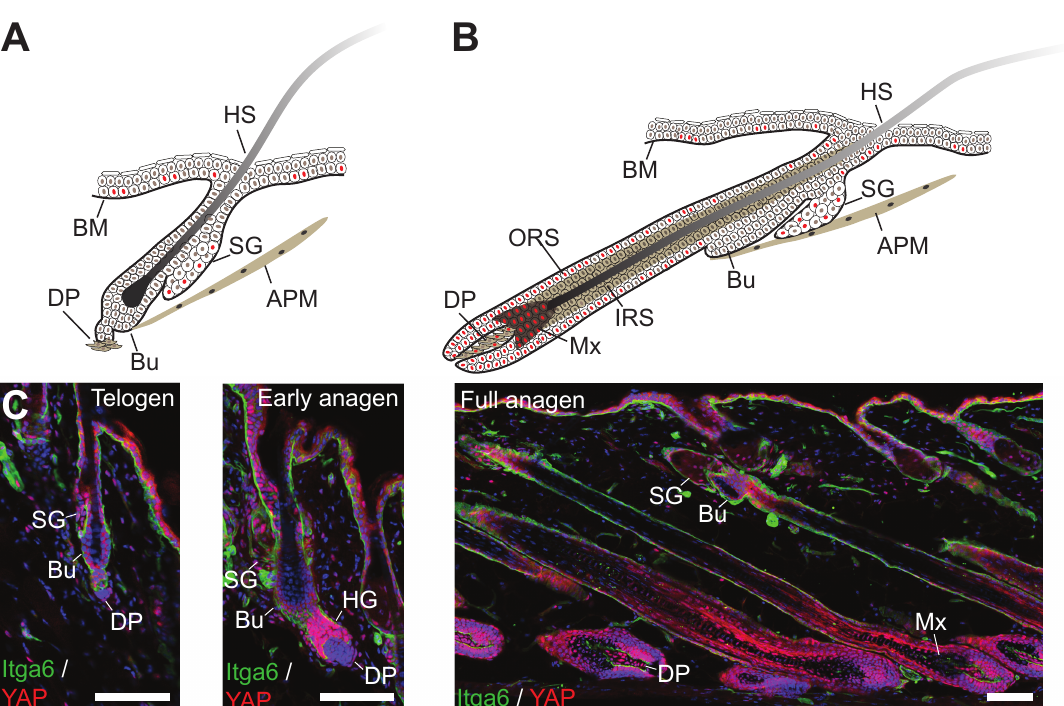
Figure 3. YAP localisation during HF cycling. ( A , B ) Schematic of a HF in the resting phase (telogen) (A) and growth phase (anagen) (B). In telogen phase, YAP is mainly localised to the cytoplasm in bulge and DP cells and there are only scattered cluster of cells with nuclear YAP in the IFE and SG. During anagen the highly proliferative cells of the ORS and HF matrix display strong nuclear YAP localisation, while YAP is cytoplasmatic in di ff erentiating cells of the IRS and HS. Beside cell clusters with nuclear YAP in the IFE and SG during anagen, some DP cells also display YAP in the nucleus. Note that only nuclear YAP is shown. ( C ) Immunostaining for YAP (red) and Itga6 (green) of mouse skin during telogen, early anagen and full anagen. Nuclei are stained with DAPI (blue). Note, the strong increase in nuclear YAP in the HG and infundibulum during anagen induction. Scale bars, 50 µ m.